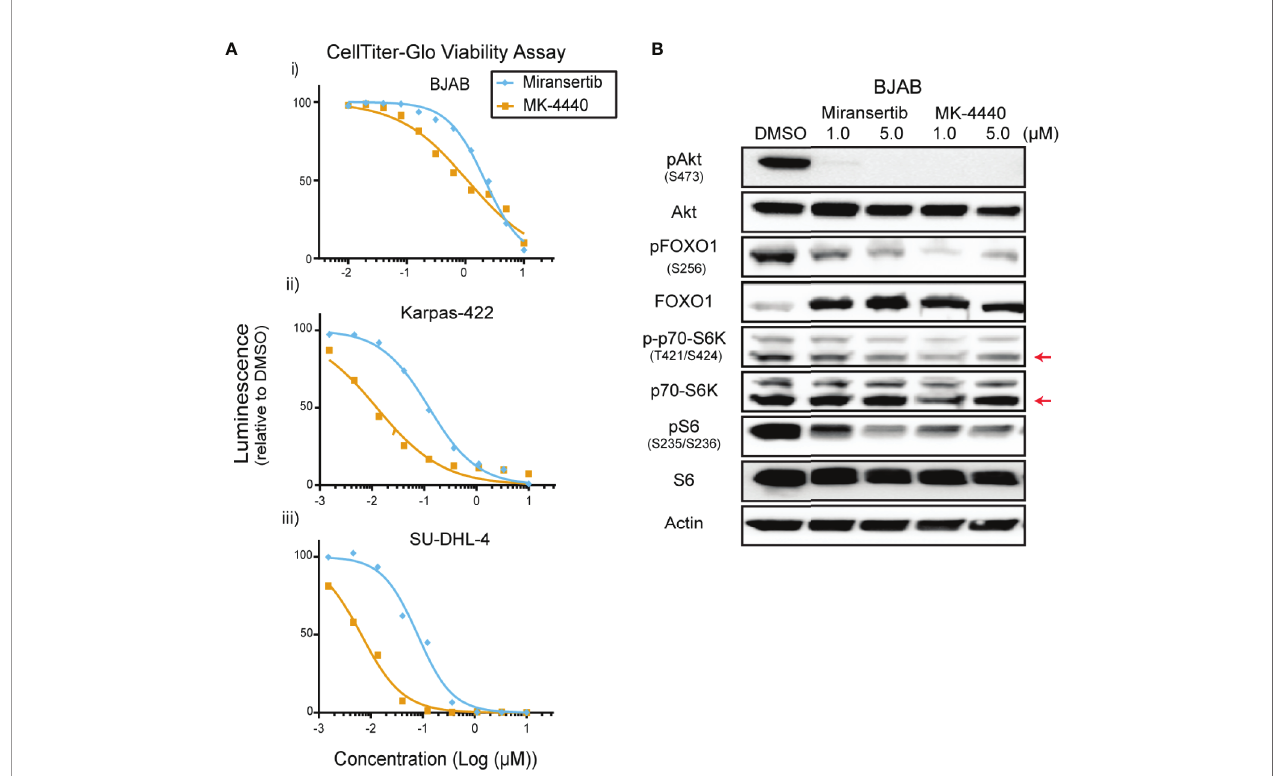
FIGURE 3 | Diffuse large B-cell lymphoma cells are sensitive to Akt inhibition by miransertib and MK-4440. (A) The DLBCL cell lines BJAB (i), Karpas-422 (ii), and SU-DHL-4 (iii) were treated for 72 h with miransertib, or MK-4440, and CellTiter-Glo was used to measure viability. (B) BJAB cells were treated for up to 72 h with miransertib, sirolimus, or the combination of both, and immunoblots performed as in Figure 1C . The red arrow points to the p70-S6K